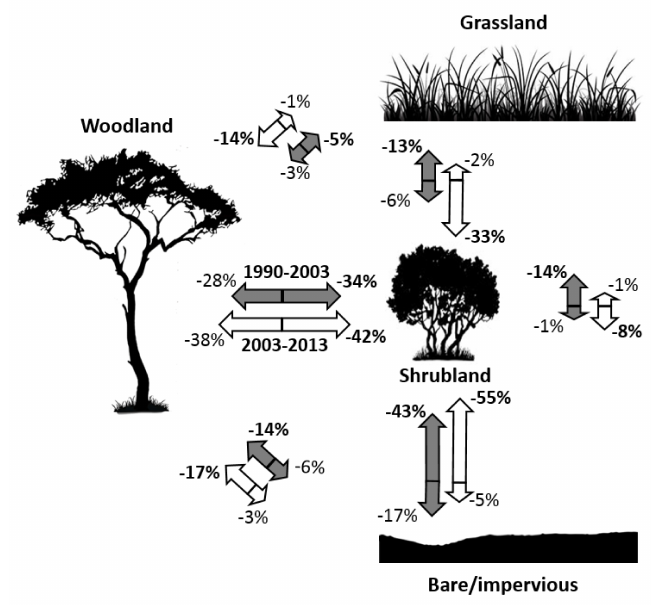
Figure 8. Dynamics of gross change among woodland, shrubland, grassland, and bare/impervious land cover in the Chobe District for 1990–2003 (gray arrows) and 2003–2013 (white arrows), represented as percent losses. Arrows indicate the direction of class losses, with arrow length scaled by change magnitude and largest transitions shown in bold. For example, from 1990–2003 34% of all woodland losses were to shrubland, while 28% of all shrubland losses were to